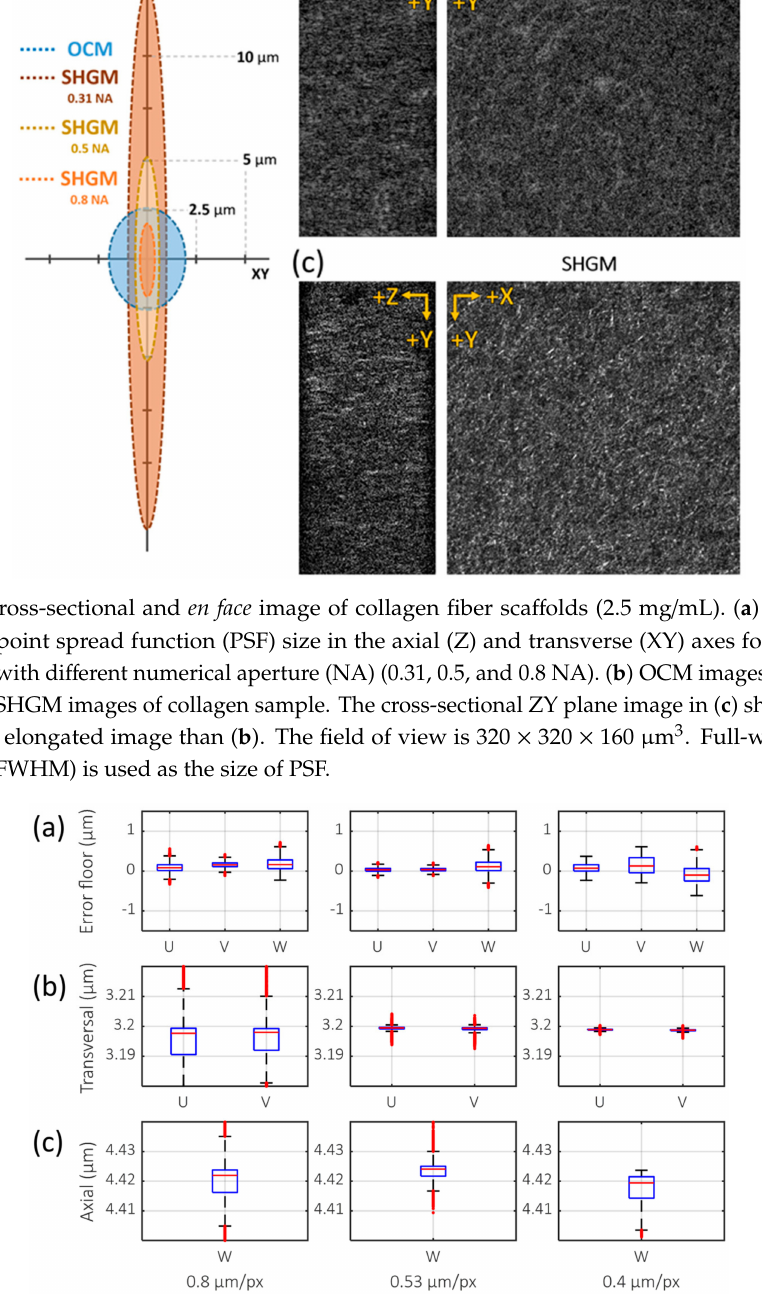
Figure 3. Boxplot of DVC analysis with various transversal sampling rates. U, V, and W indicate deformation in X-, Y-, and Z-directions, respectively. ( a ) Error floor and ( b ) virtual translation in the transverse axis, 3.20 µ m in U and V. ( c ) Virtual translation in the axial axis, 4.42 µ m in W. The red horizontal line is the median value. The top and bottom of blue box indicates the 25th and 75th percentiles. Red crossmark outside of the box denotes